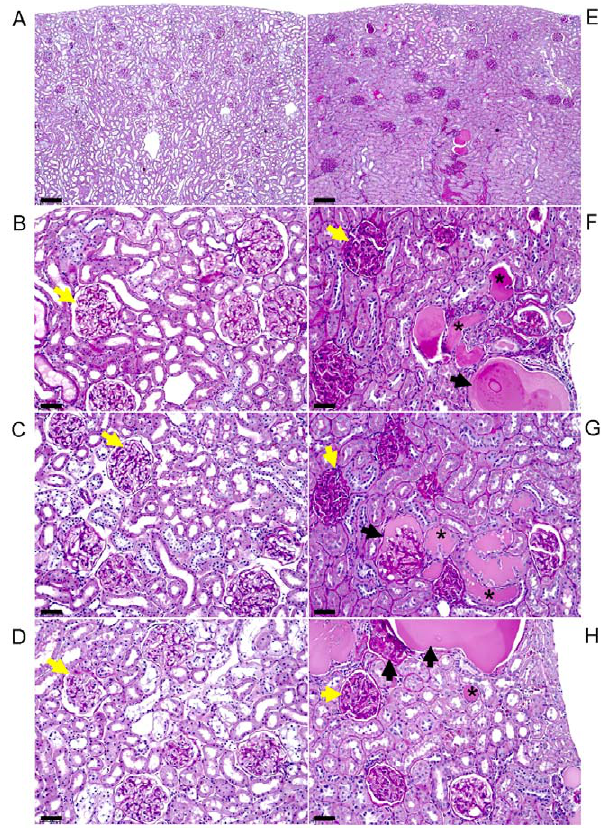
Figure 2. Representative Periodic Acid Schiff (PAS)-stained photomicrographs of rat kidneys with low ( # 115) and high ( $ 265) glomerular injury scores (GIS). A. Low magnification view of representative rat kidney section with low GIS, and (B–D) high magnification view of three representative rat kidney sections with low GIS scores demonstrate mild PAS-staining (magenta) of glomerular mesangial matrix and basement membranes, minimal PAS-staining of tubular basement membranes and tubular casts, and no glomerular sclerosis. In contrast, E, low magnification view of representative rat kidney section with high GIS, and (F–H) high magnification view of three representative rat kidney sections with high GIS show increased number of PAS-stained glomeruli with thickened mesangial matrix and basement membranes, glomerular sclerosis, tubular casts and PAS- stained thickened tubular basement membranes. Yellow , glomeruli, sclerotic glomeruli, *, tubular casts, bar=200 micron (A, E), 50 microns (B–D, E–H).